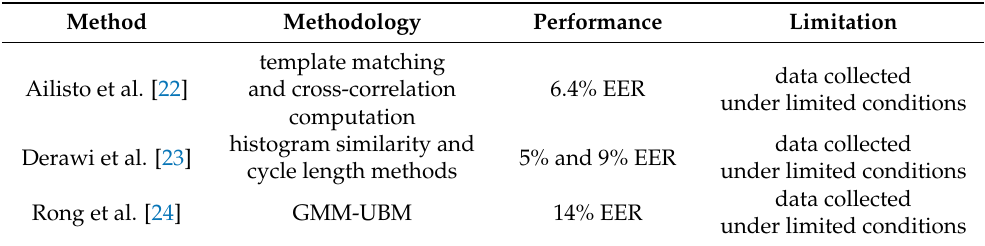
Table 1. The summary of the pattern recognition studies for gait recognition. Method Methodology Performance Limitation template matching data collected Ailisto et al. [22] and cross-correlation 6.4% EER under limited conditions computation histogram similarity and data collected Derawi et al. [23] 5% and 9% EER cycle length methods under limited conditions data collected Rong et al. [24] GMM-UBM 14% EER under limited